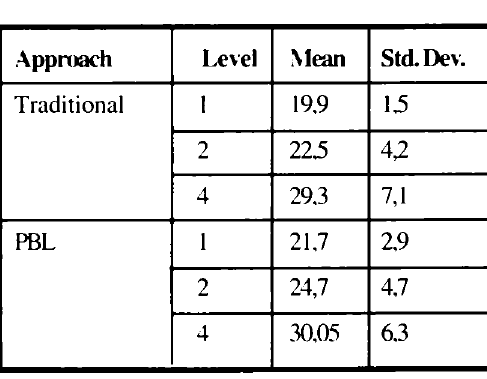
Table 3:Total mean scores of clinical reasoning abilities of all